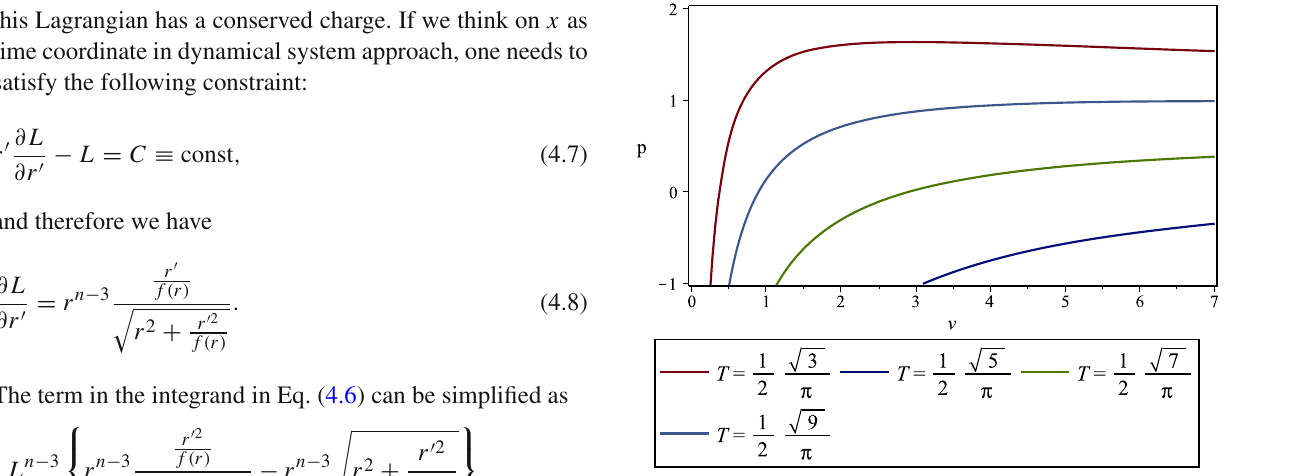
Fig. 14 P – V diagrams for the thermodynamic volume and pressure for five dimensional SAdS black holes